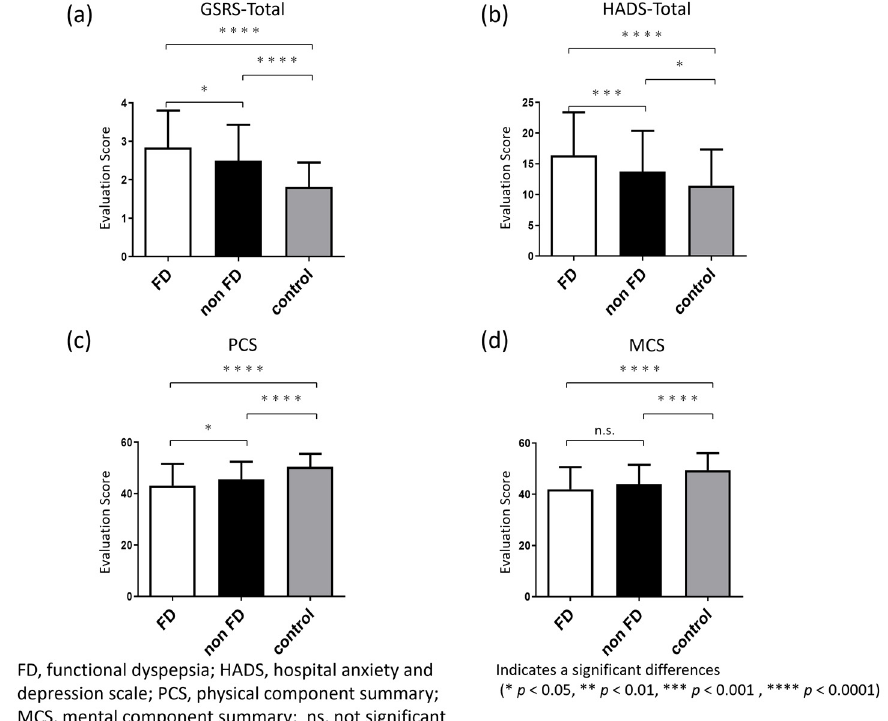
Figure 3. GSRS, psychological and general QOL score of FD and non-FD patients. ( a , b ) The total GSRS and HADS score were significantly higher in FD group than non-FD group, which was higher than the control group; ( c , d ) Physical and mental component summary scores were significantly lower in FD and non-FD patients than in the control group, and PCS was also significantly lower in the FD group than in the non-FD group. No significant difference was observed between the FD and non-FD groups.